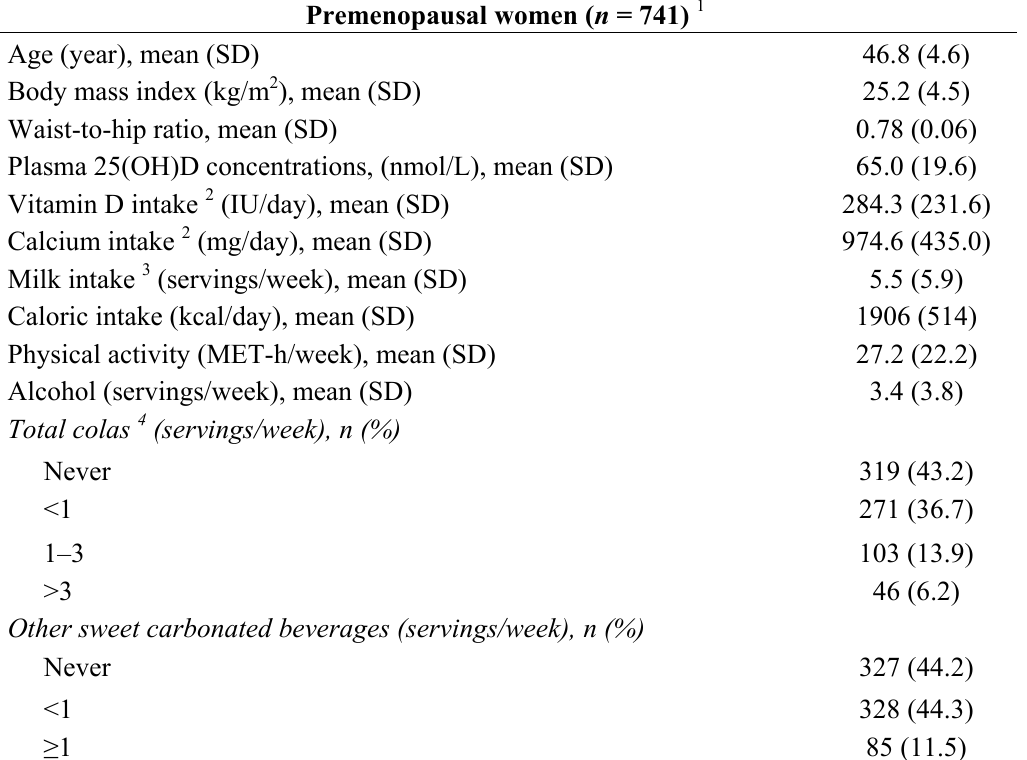
Table 1. Characteristics of the study